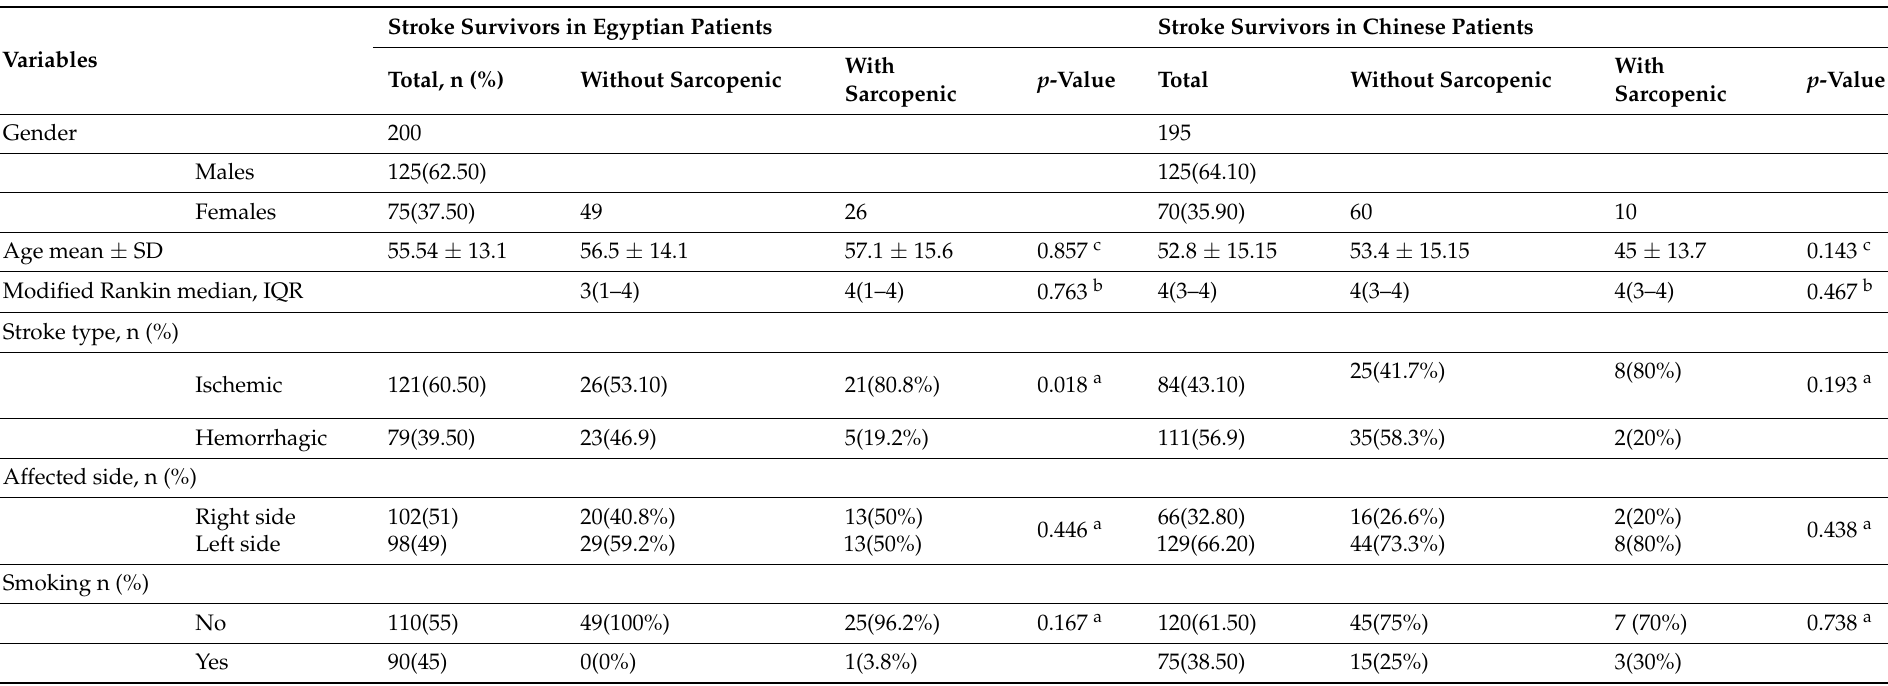
Table 2. The basic characteristic of stroke survivors between the Egyptian versus Chinese female patients with or without